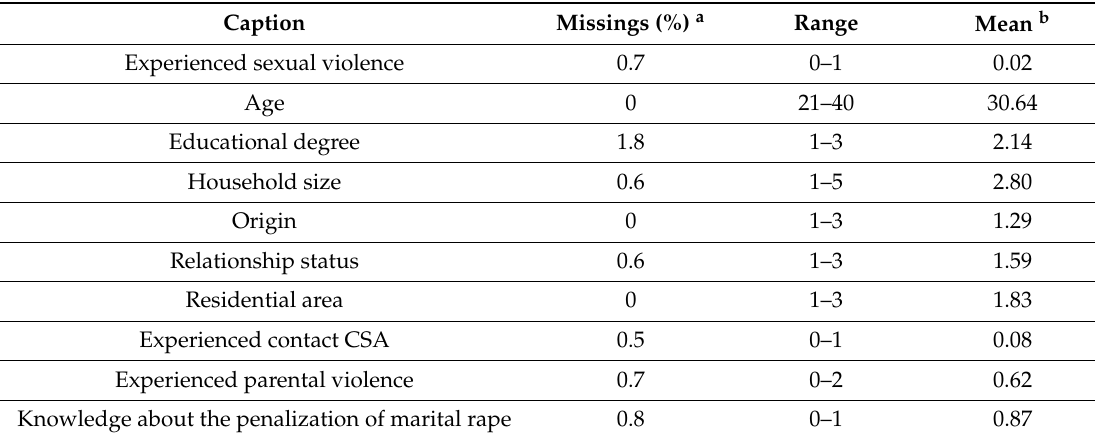
Table 1. Descriptive statistics for all variables used in the C-Tree